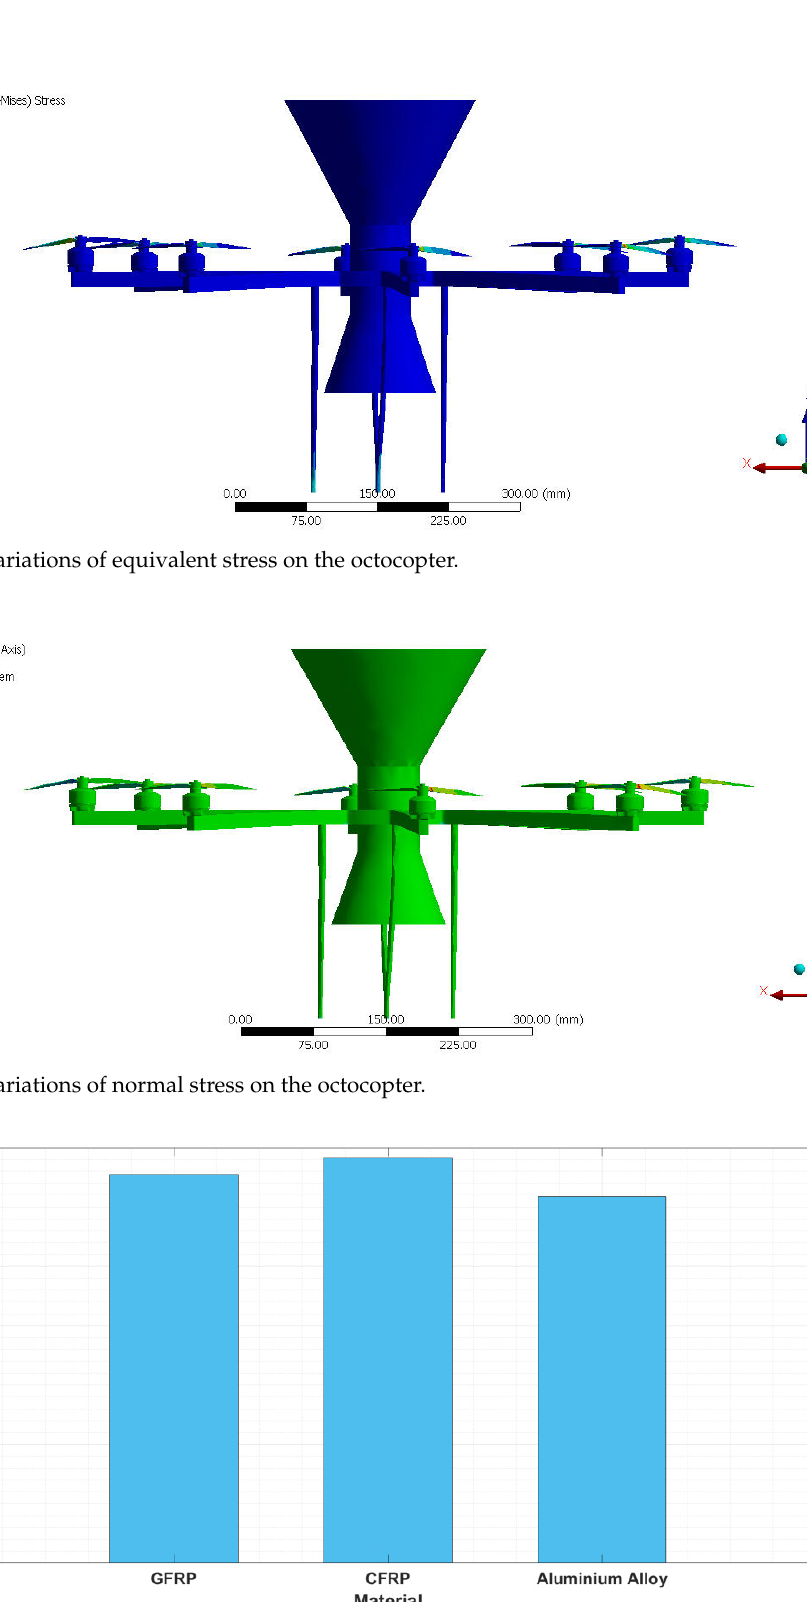
Figure 36. Comparative equivalent stress variations on the primary aerospace materials (including glass-fiber-reinforced polymer (GFRP) and carbon-fiber-reinforced polymer (CFRP).